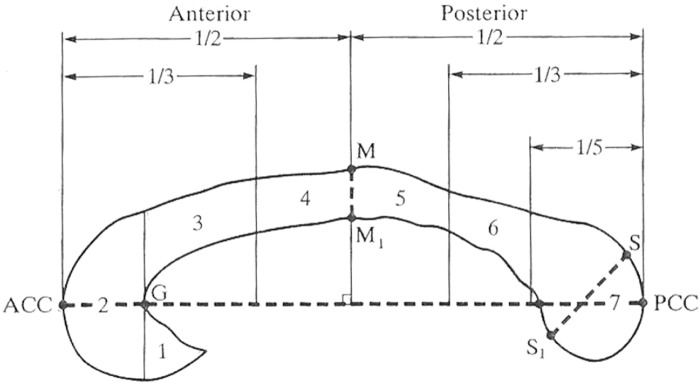
Regional subdivisions of the corpus callosum based on Witelson et al. (1989) and Venkatasubramanian et al. (2007).Subregions: (1) rostrum, (2) genu, (3) rostral body, (4) anterior midbody, (5) posterior midbody, (6) isthmus, (7) splenium.